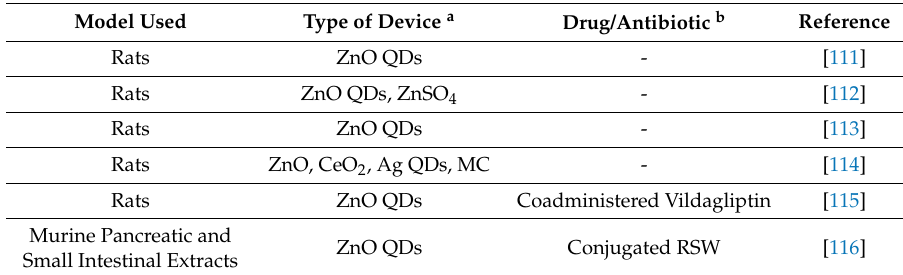
Table 4. ZnO nanoplatforms for diabetes